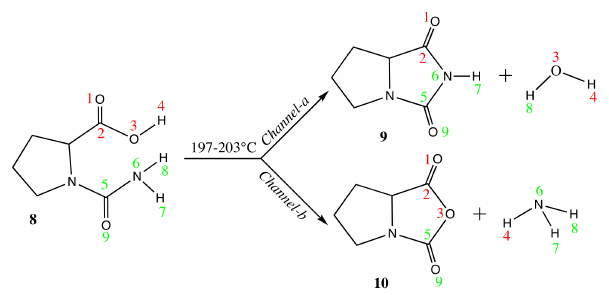
Scheme 8. Thermal decomposition of